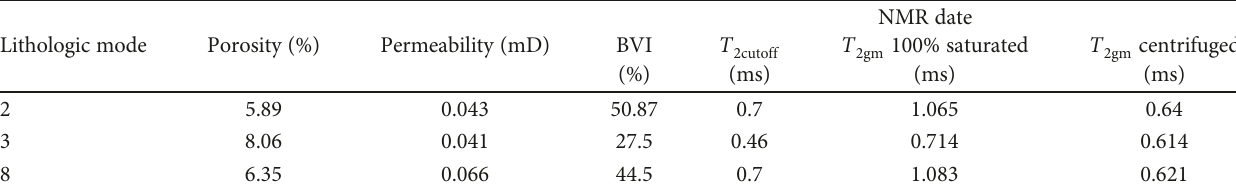
Table 2: NMR parameters of the three typical reservoir